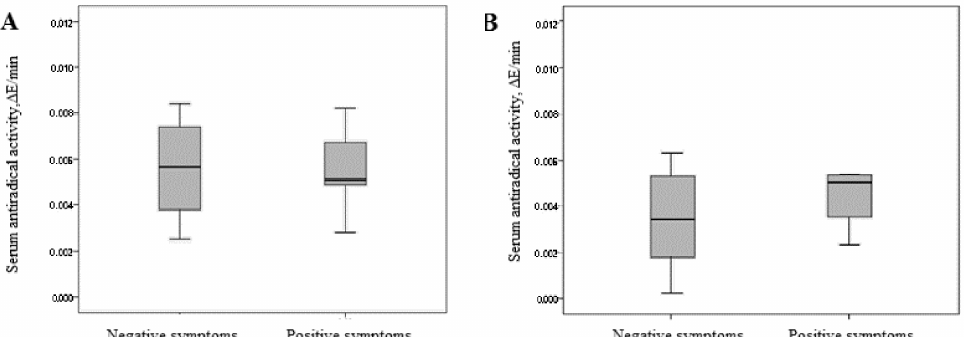
Figure 7. TAC of blood serum in patients with schizophrenia depending on the leading sympto- mology. ( A ) Patients with schizophrenia in remission. ( B ) Patients with acute schizophrenia. Note: ∆ E/min—change in the optical density of the solution per